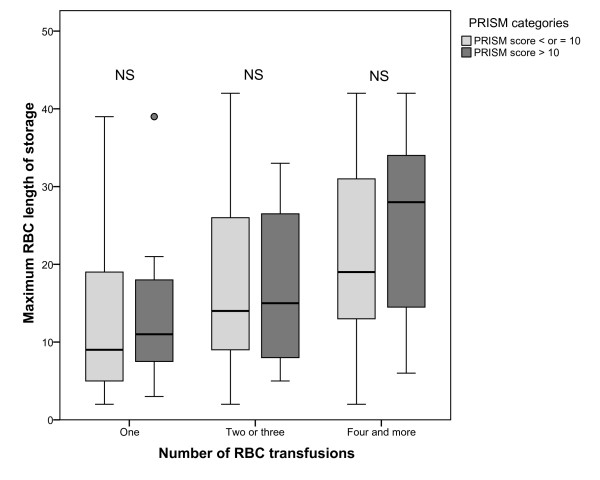
Box plot of the maximum RBC length of storage, according to the number of RBC transfusions and according to the severity of disease at admission (PRISM III score ≤ 10 versus >10). RBC, red blood cell; PRISM, pediatric risk of mortality; NS, not significant.